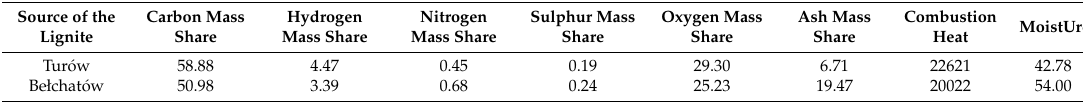
Figure 1. Location of the Bełchatów and Turów power plants on the Polish map. Table 1. Characteristics of the lignite under investigation.